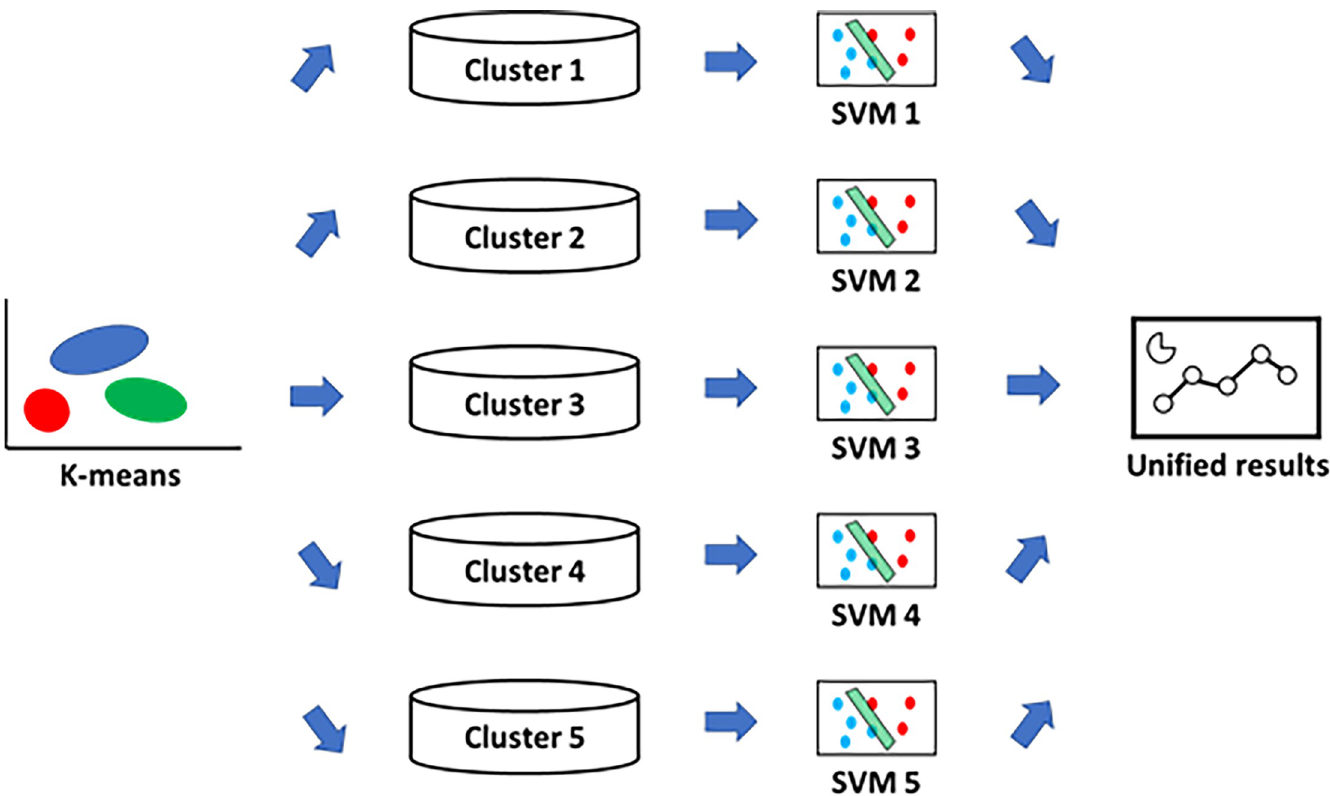
Fig 2. Structure of ensemble model. The patients were grouped into five clusters using the K-means method. Each cluster was analyzed using each SVM model. The results of analysis using SVM models were unified. Abbreviation: SVM, support vector machine.